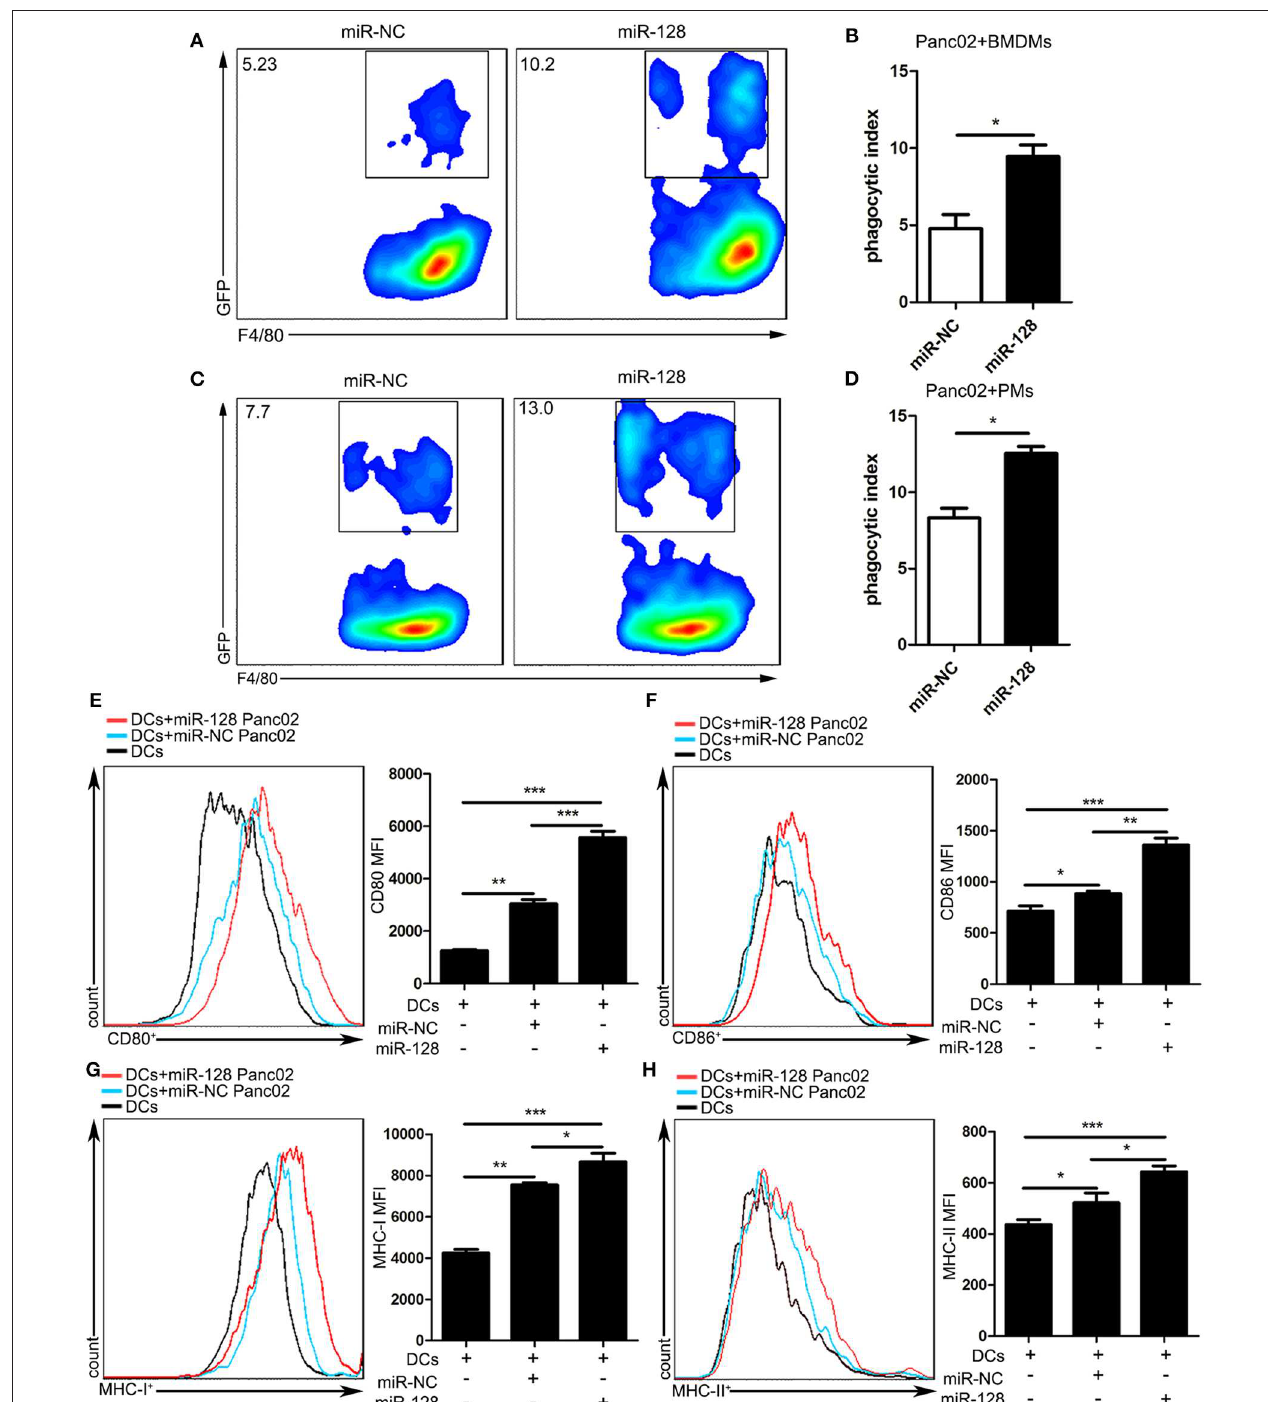
FIGURE 4 | Overexpression of miR-128 in Panc02 cells enhanced the phagocytosis of macrophages and the activity of DCs. miR-NC or miR-128 overexpression Panc02 cells were incubated with mouse bone-marrow-derived macrophages (BMDMs) or peritoneal-cavity-derived macrophages for 4 h, stained with F4/80-APC antibody, and analyzed by flow cytometry. (A,C) Representative plots show the percentage of F4/80 + GFP + macrophages phagocytosing cancer cells among F4/80 + BMDMs and peritoneal-cavity-derived macrophages. (B,D) Statistical analysis of the phagocytosis of cancer cells by both BMDMs and peritoneal-cavity-derived macrophages. MiR-NC or miR-128 overexpression Panc02 cells were incubated with mouse bone-marrow-derived dendritic cells (BMDCs) for 48 h. The expression of costimulatory molecules CD80 (E) and CD86 (F) and antigen peptides MHC-I (G) and MHC-II (H) on DCs were analyzed by flow cytometry. These results represent the mean ± SEM from three independent experiments. Comparisons among three groups were determined by ANOVA. * p < 0.05, ** p < 0.01, and *** p < 0.001.